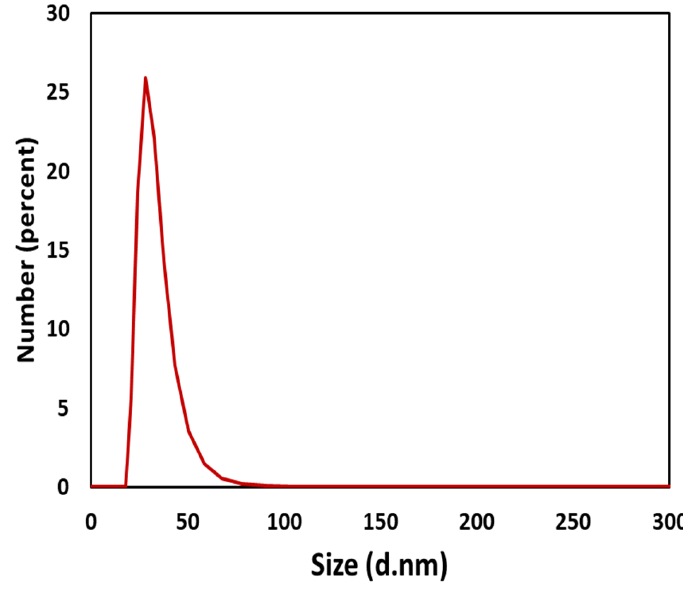
Figure 5. DLS diagrams of AgNPs functionalized by extract of teucrium apollinis.